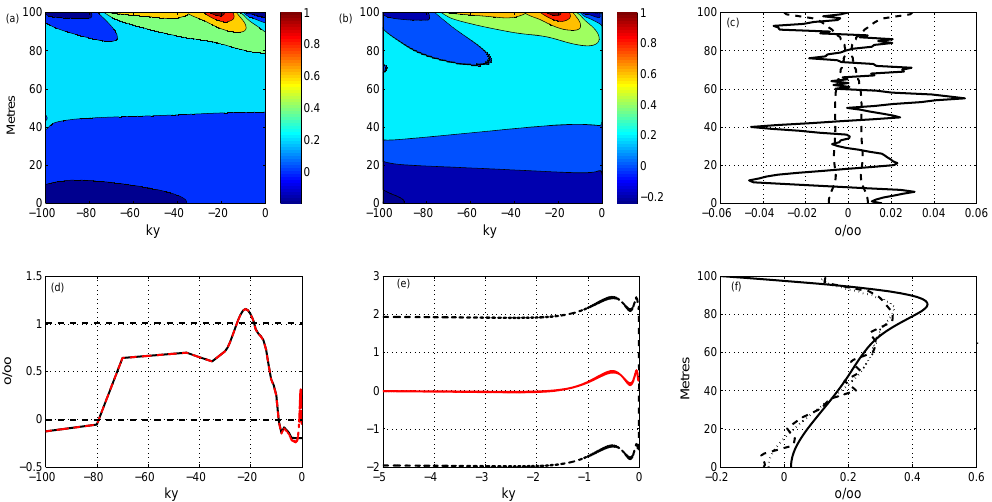
Figure 11. Core 1063 with the sea level prior, periodic initial conditions, and a solution forced to reproduce the local maximum through the terminal uncertainty estimate (small R ). All residual structures would be noise of an unknown nature. The C h ( t ) maximum does exceed the estimated volumetric global mean, but the uncertainties remain close to ± 2‰ . Again, pinched error bars in (c) show the forcing to the local maximum visible in (f) . This solution is most like those discussed in the earlier literature, fitting only to the local maximum and treating all other structures as